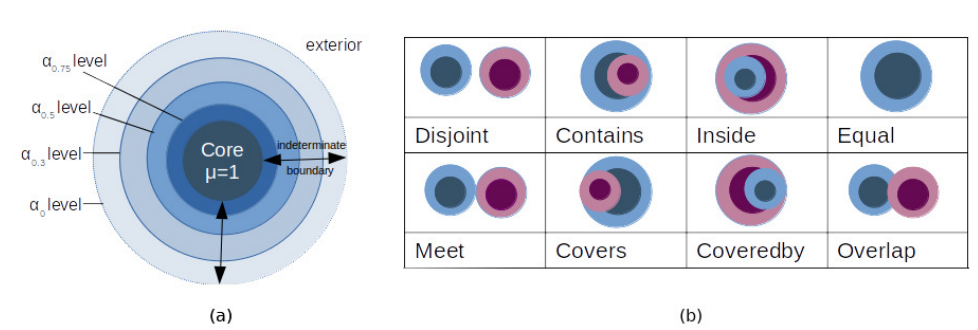
Figure 1. ( a ) Visualization of a simple fuzzy region. ( b ) Examples of topological relations between fuzzy